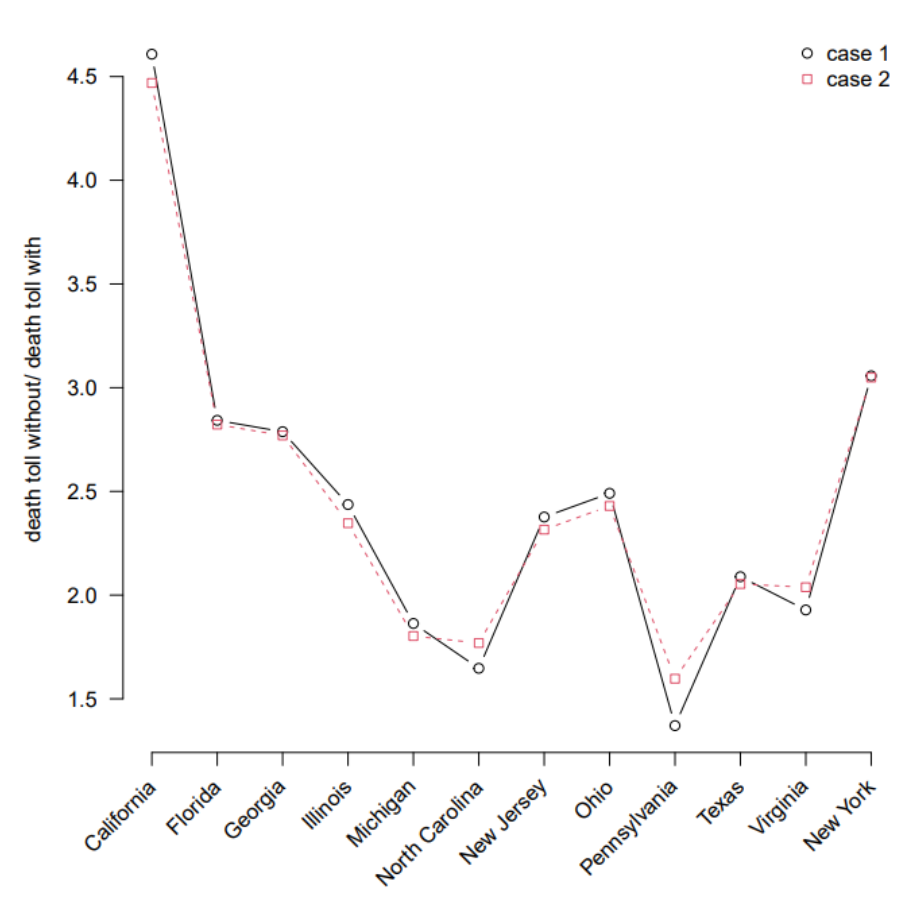
Figure 4. The ratio of estimated total deaths in the two scenarios for the 12 states in US with the highest population size fitted under the two approaches. Case 1 ( ψ = 1, η = 0.85) and Case 2 ( ψ = 0.15, η = 0) are the two special cases we listed in the Methods section.